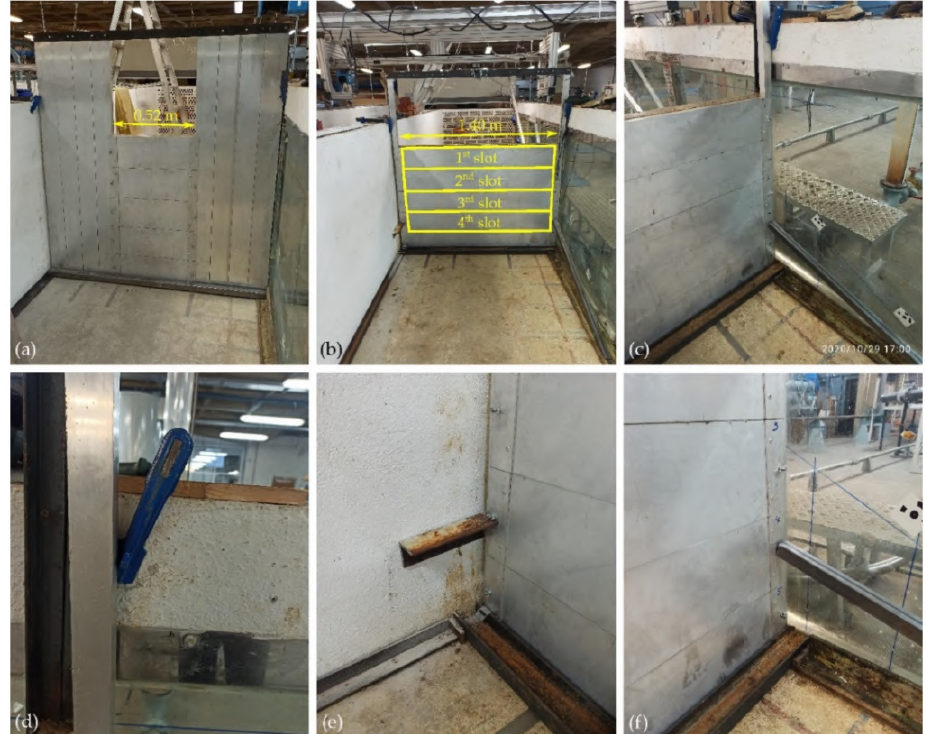
Figure 4. Images of the aluminum protection system for the simulation of the support of the core on the downstream shoulder: ( a ) Smaller unprotection width; ( b ) Larger unprotection width; ( c ) Detail of the ‘1/3’ height metallic supports on the left wall of the flume; ( d ) Detail of the clamps used to support the upper section; ( e ) Detail of the metallic supports on the right wall of the flume; ( f ) Detail of the metallic supports on the left wall of the